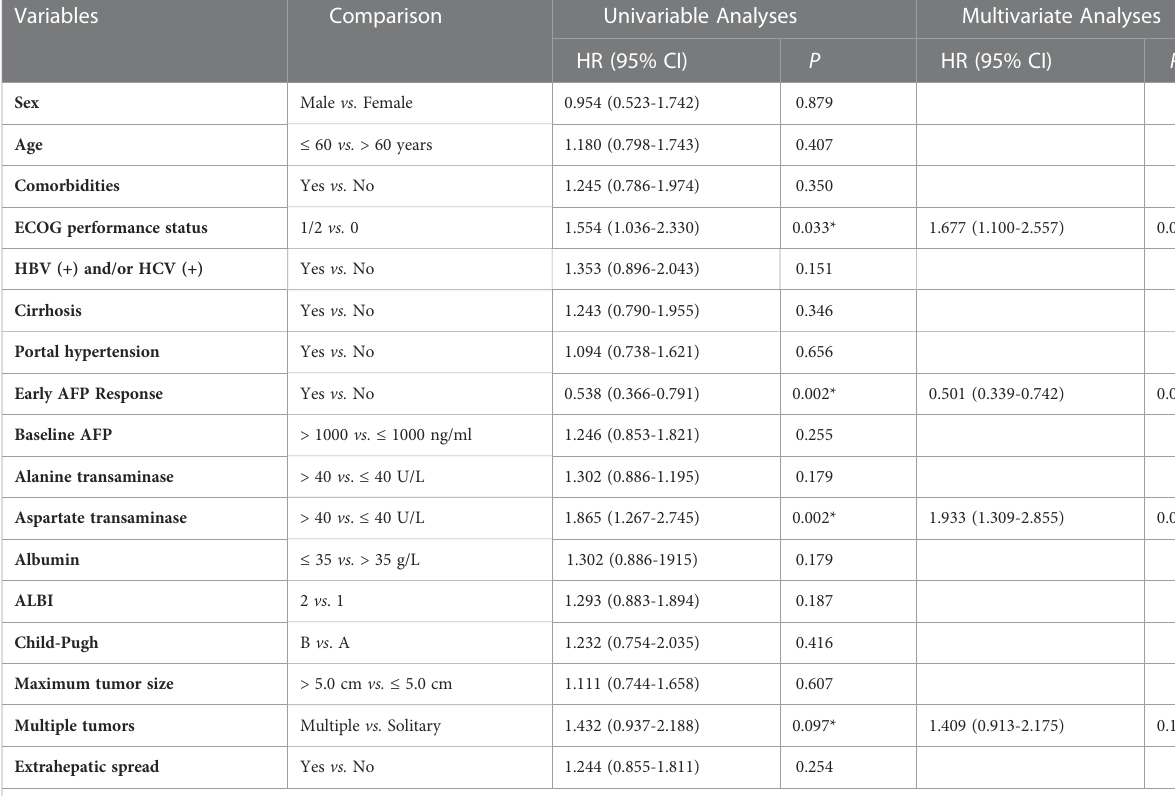
TABLE 4 Univariate and multivariate Cox regression analyses predicting progression-free